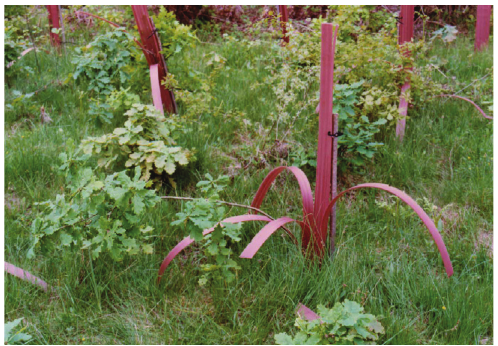
FIGURE 2 . An inadequate structure and compo- sition of the shelter causing their premature de-